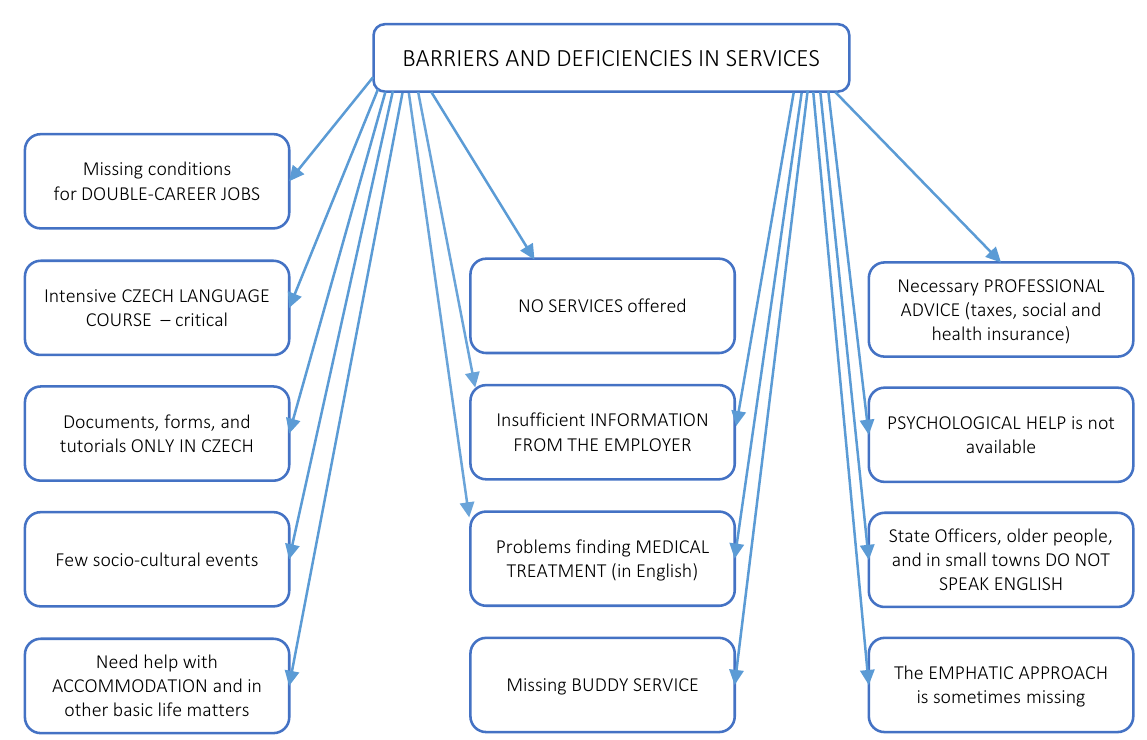
Figure 2. Barriers to integration related to deficiencies in